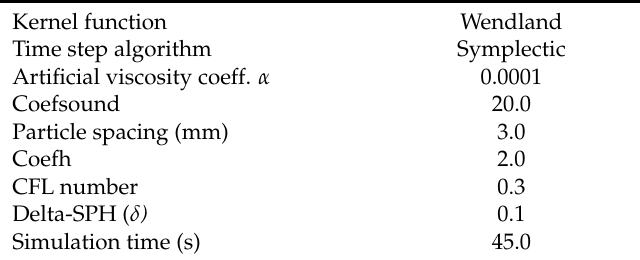
Table 4. Total number of particles for three water depths.